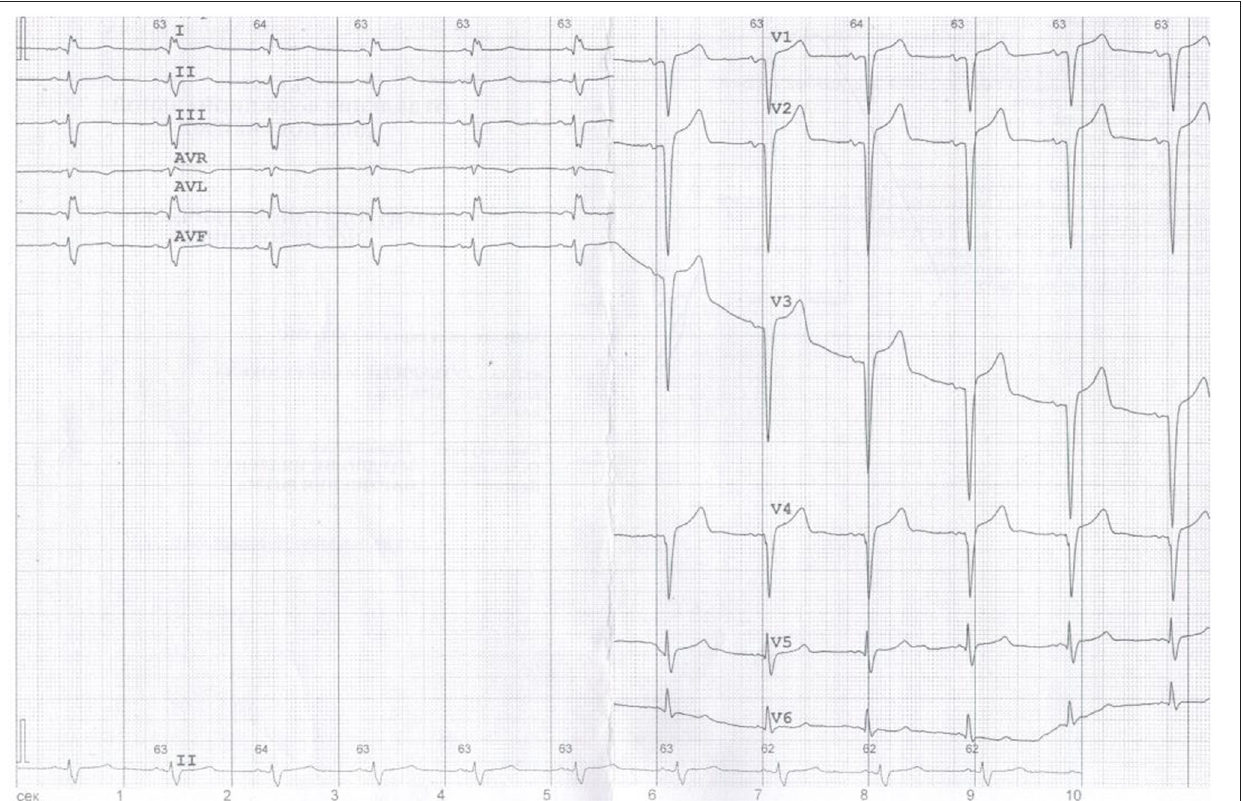
FIGURE 2 | ECG: Sinus tachycardia, heart rate (HR) 63bpm, left anterior fascicular block, QS-pattern in leads V1–V3.